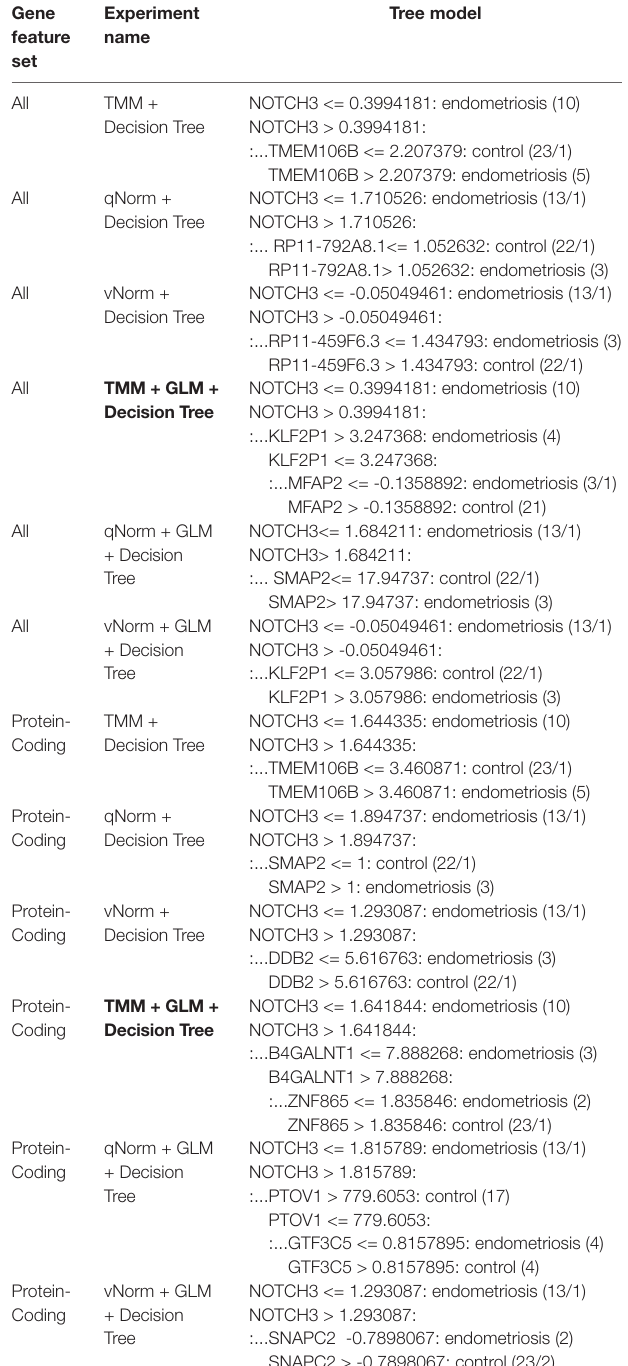
TABLE 3 | Decision tree models using transcriptomics